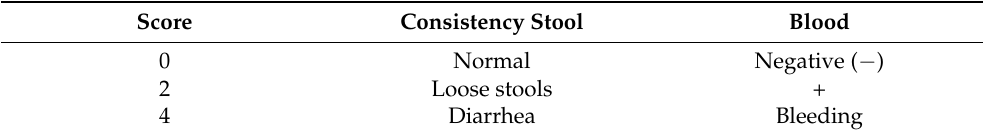
Table 2. Disease activity index calculation